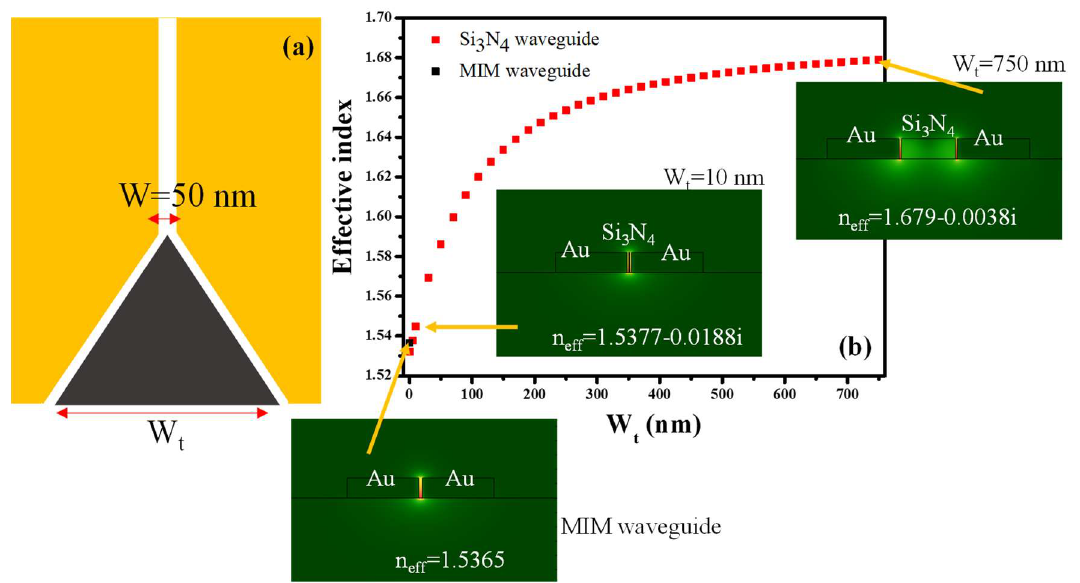
Figure 6. ( a ) Schematic representation of a mode converter integrated with a MIM waveguide; ( b ) Effective index versus tapered waveguide width. Inset shows the E-field distribution and effective index in the waveguide at a different position along the tapered waveguide.